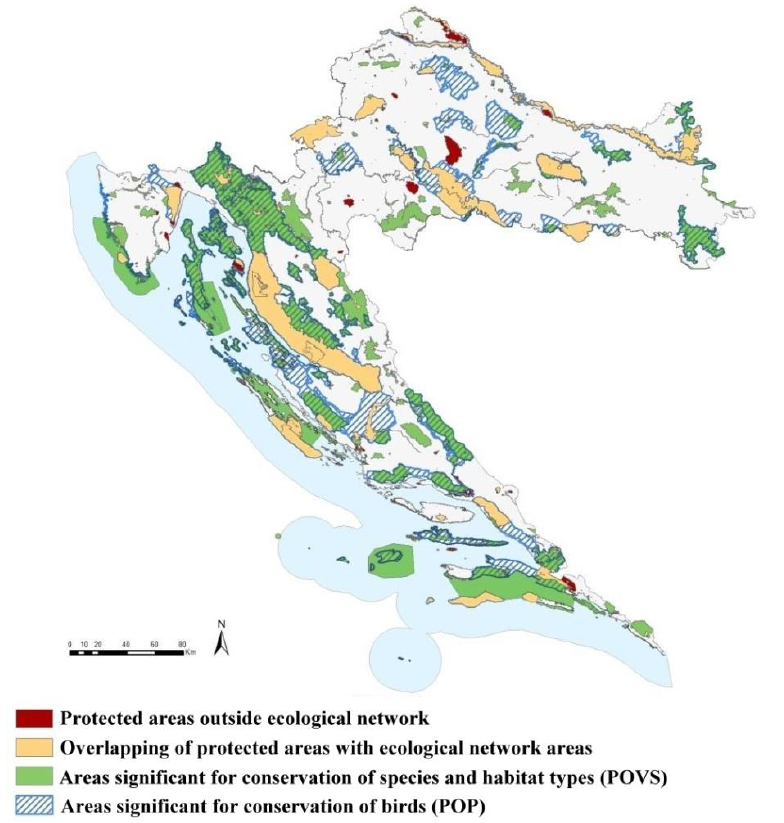
Figure 2. Map showing the protected areas and areas of ecological